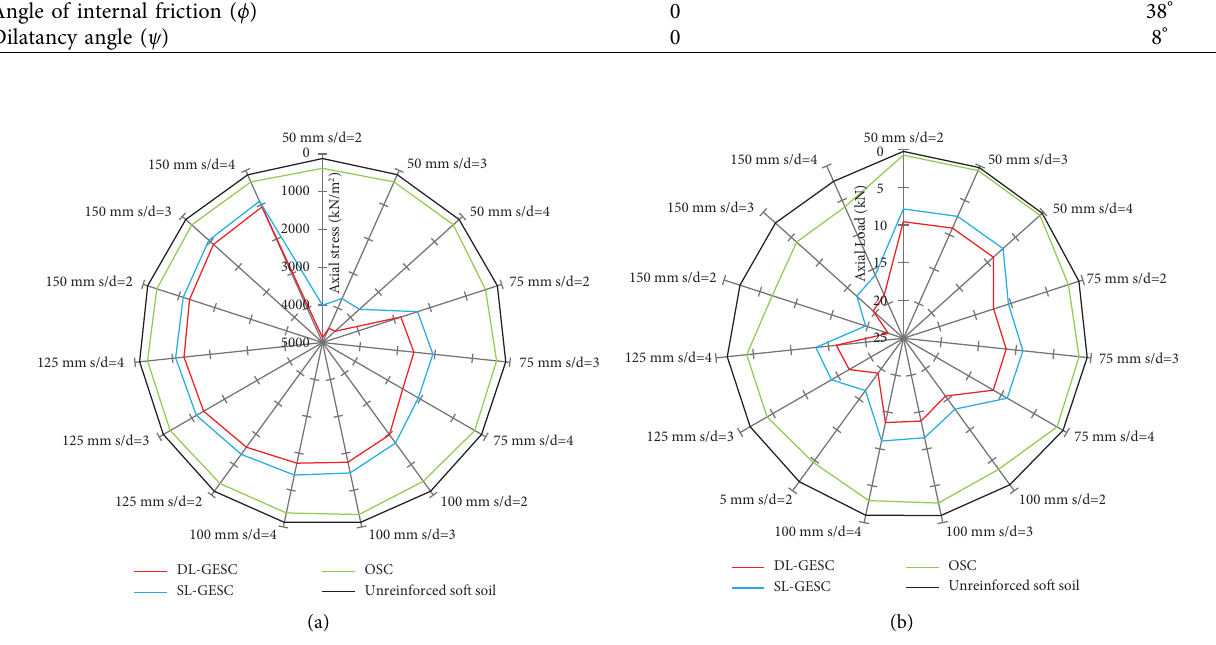
Figure 6: Efect of spacing on a single column: (a) axial stress (kN/m 2 ) and (b) load (kN).